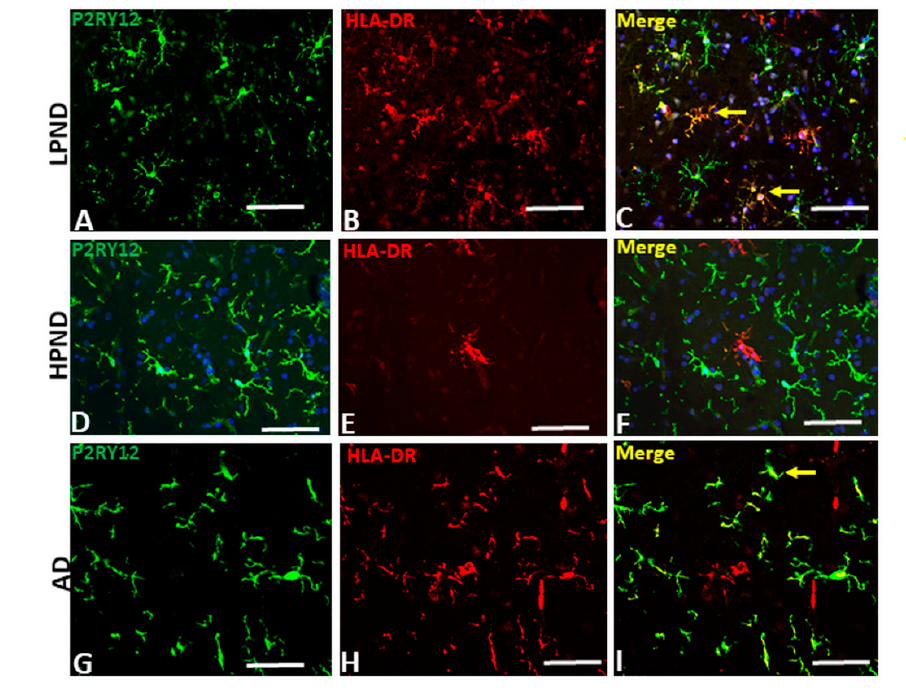
Figure 6. Confocal microscopy of P2RY12 and HLA-DR positive microglia in pathologically staged cases. ( A – I ) Images of P2RY12 (green), HLA-DR (red) and merged (yellow) with DAPI (blue) in MTG